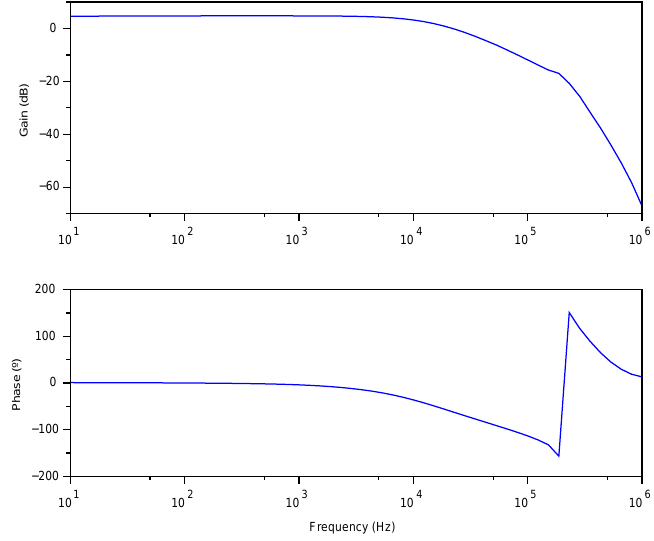
Figure 11. Bode plot of the gain of the Analog